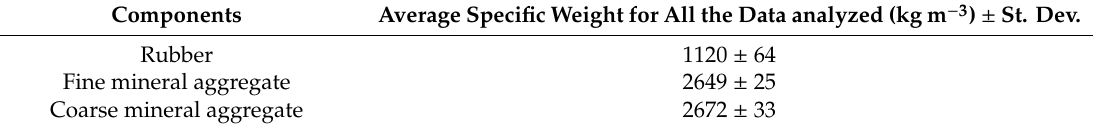
Table 2. Weight parameters adopted for the data